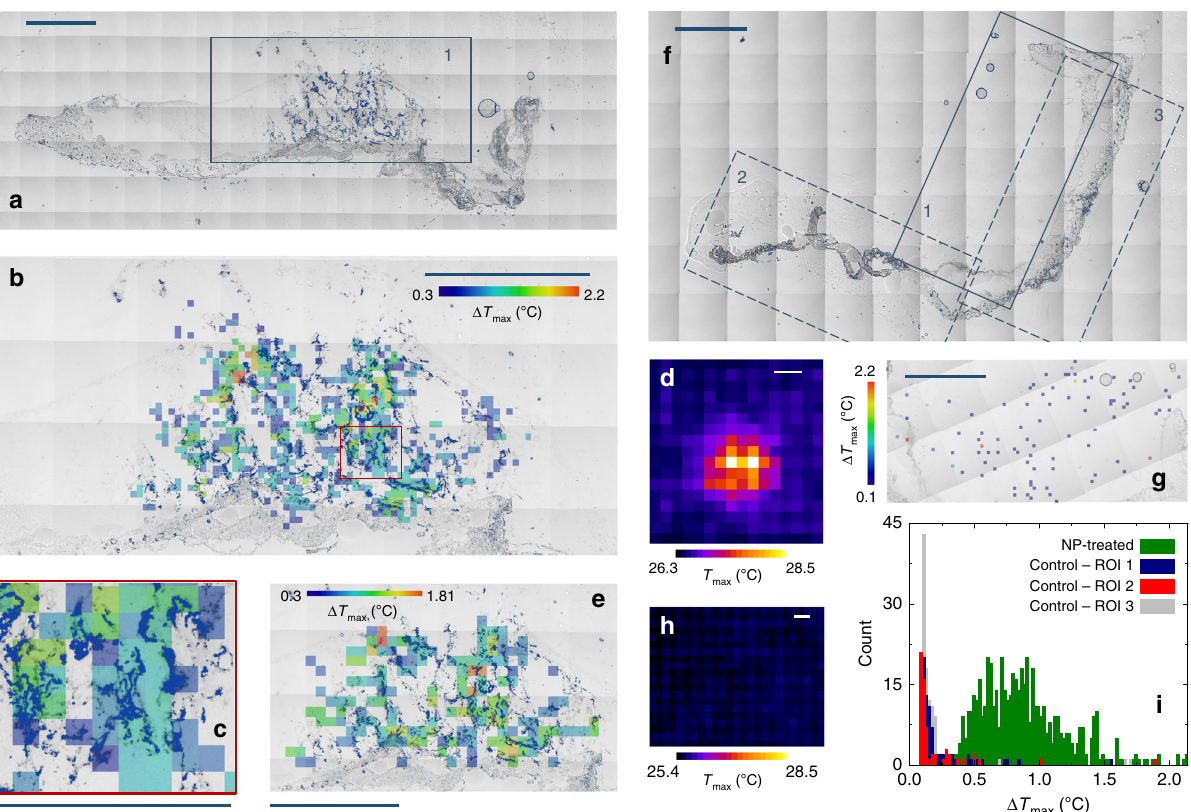
Fig. 3 Sub-diffraction thermal imaging on murine biopsies. a Transmitted-light tile-scan image of an explanted murine skin biopsy treated with 30-nm PB nanocubes, which are highlighted in navy by an upper threshold on intensity counts. b Super-resolution image of ROI 1 in a ( N x x N y = 100 × 48, δ x = 37.6 μ m, Δ x = 50, Δ y = 1, τ on = 1 s, P = 15 mW, beam 1/e 2 diameter 22 ± 1 μ m, Δ T min = 0.3 °C) overlaid to the transmitted-light image (nanocubes in navy as in a ). c Magni fi cation of the red boxed region in b . d Temporal maximum projection of the thermo-camera stack employed for b . e Same as b with doubled pixel size ( N x x N y = 50 × 24, δ x = 75.3 μ m, Δ x = 25, Δ y = 2), overlaid to the transmitted-light image (nanocubes highlighted in navy as in a ); only a 2.7 × 1.6 mm 2 ROI is shown for the sake of display. f Transmitted-light tile-scan image of a nanoparticle-untreated explanted murine skin biopsy; pixels